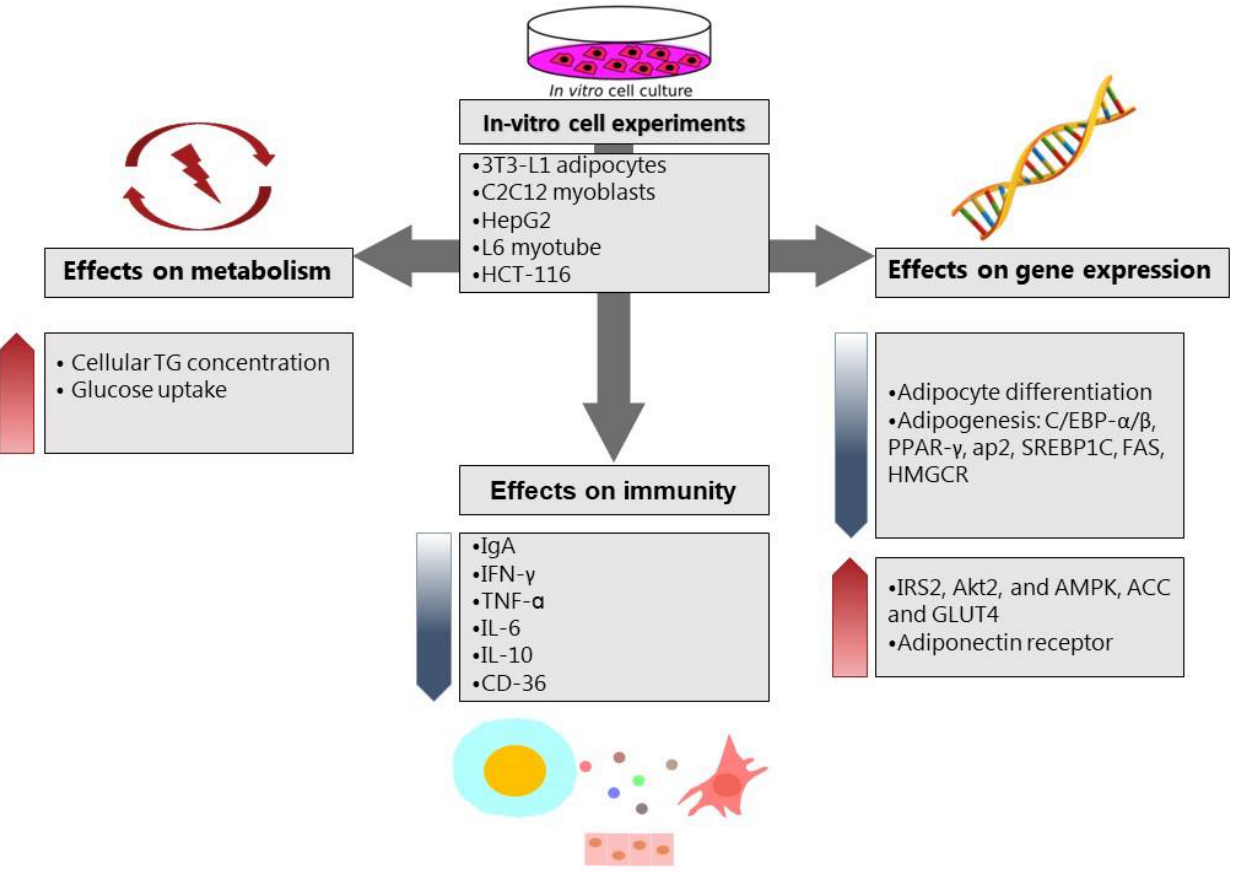
Figure 1. The effects of various fermented foods on metabolism, immunity, and gene expression of metabolic factors in cell culture studies. Abbreviations: TG: triglyceride, IgA: immunoglobulin A, IFN- γ: interferon - γ, TNF - α: tumor necrosis factor - α, IL -6: interleukin-6, IL-10: interleukin-10, CD- 36: cluster of differentiation-36, C/EBP- α/β: CCAAT/enhancer -binding protein- α/β, PPAR - γ: Perox- isome proliferator-activated receptor- γ, AP -2: adaptor protein complex-2, SREBP-1c: sterol regula-